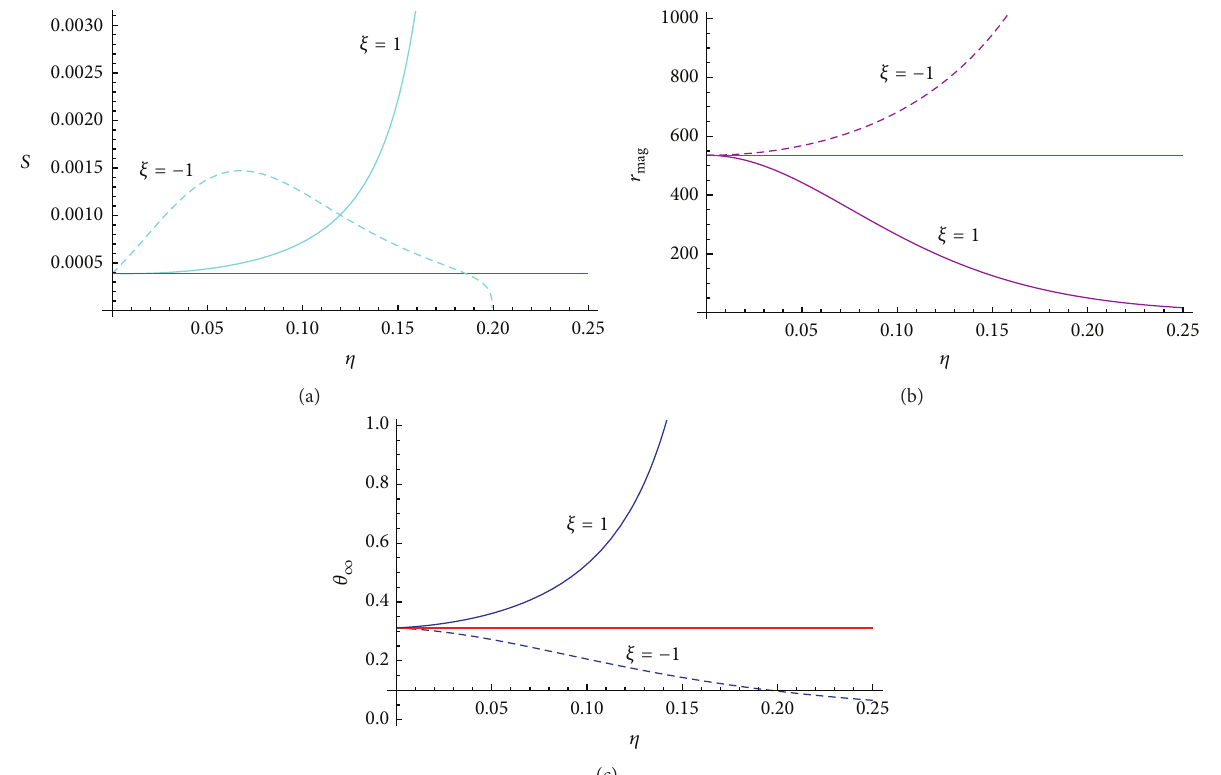
Figure 6: Plots of the observables corresponding to 𝜂 . Red line shows the value for the Schwarzschild BH.